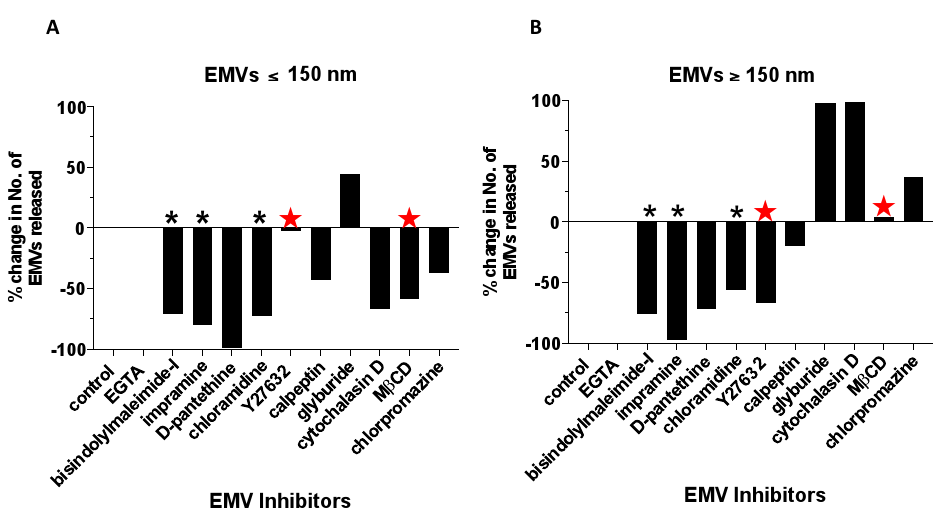
Figure 3. Size exclusion analysis of the NTA data, considering vesicles ≤ 150 nm ( A ) or ≥ 150 nm ( B ), indicates percentage changes in number of exosome-sized vesicles ( A ) versus MV-sized vesicles ( B ) respectively. M β CD, which only reduced exosome-sized vesicles ( ≤ 150 nm), and Y27632, which only reduced MV-sized vesicles ( ≥ 150 nm), are both indicated by red stars. Cl-amidine, bisindolylmaleimide-I, and imipramine, which inhibited both exosome-sized and MV-sized vesicles, are indicated by black asterisks.